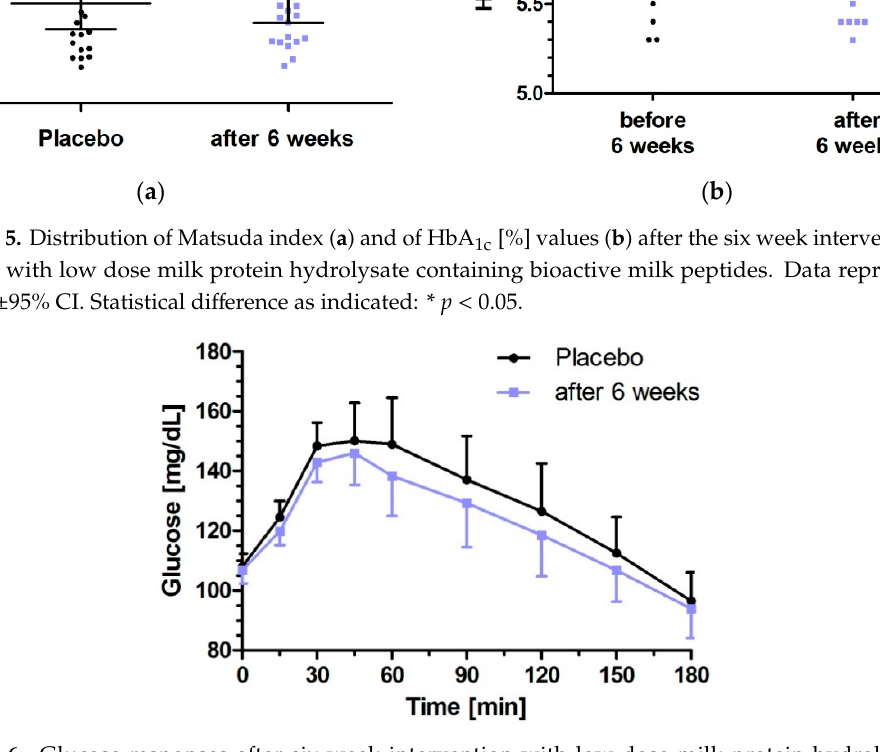
Figure 6. Glucose responses after six week intervention with low dose milk protein hydrolysate containing bioactive milk peptides and after challenge meal. Data represent mean ±95% CI.